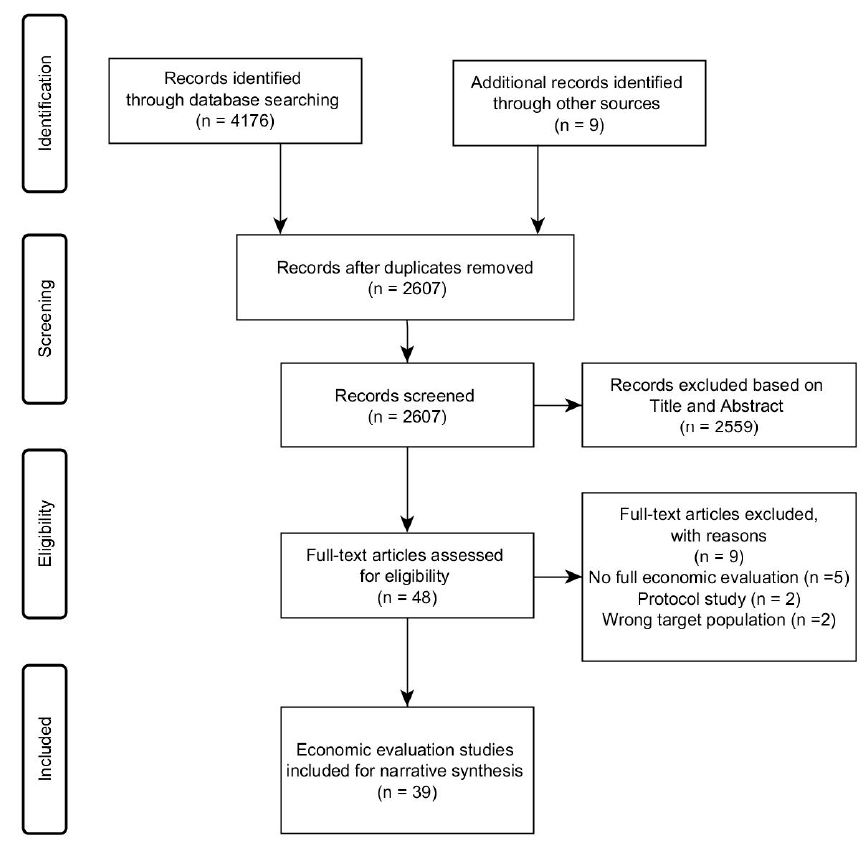
Figure 1. PRISMA (Preferred Reporting Items for Systematic Reviews and Meta-Analyses) flow diagram.